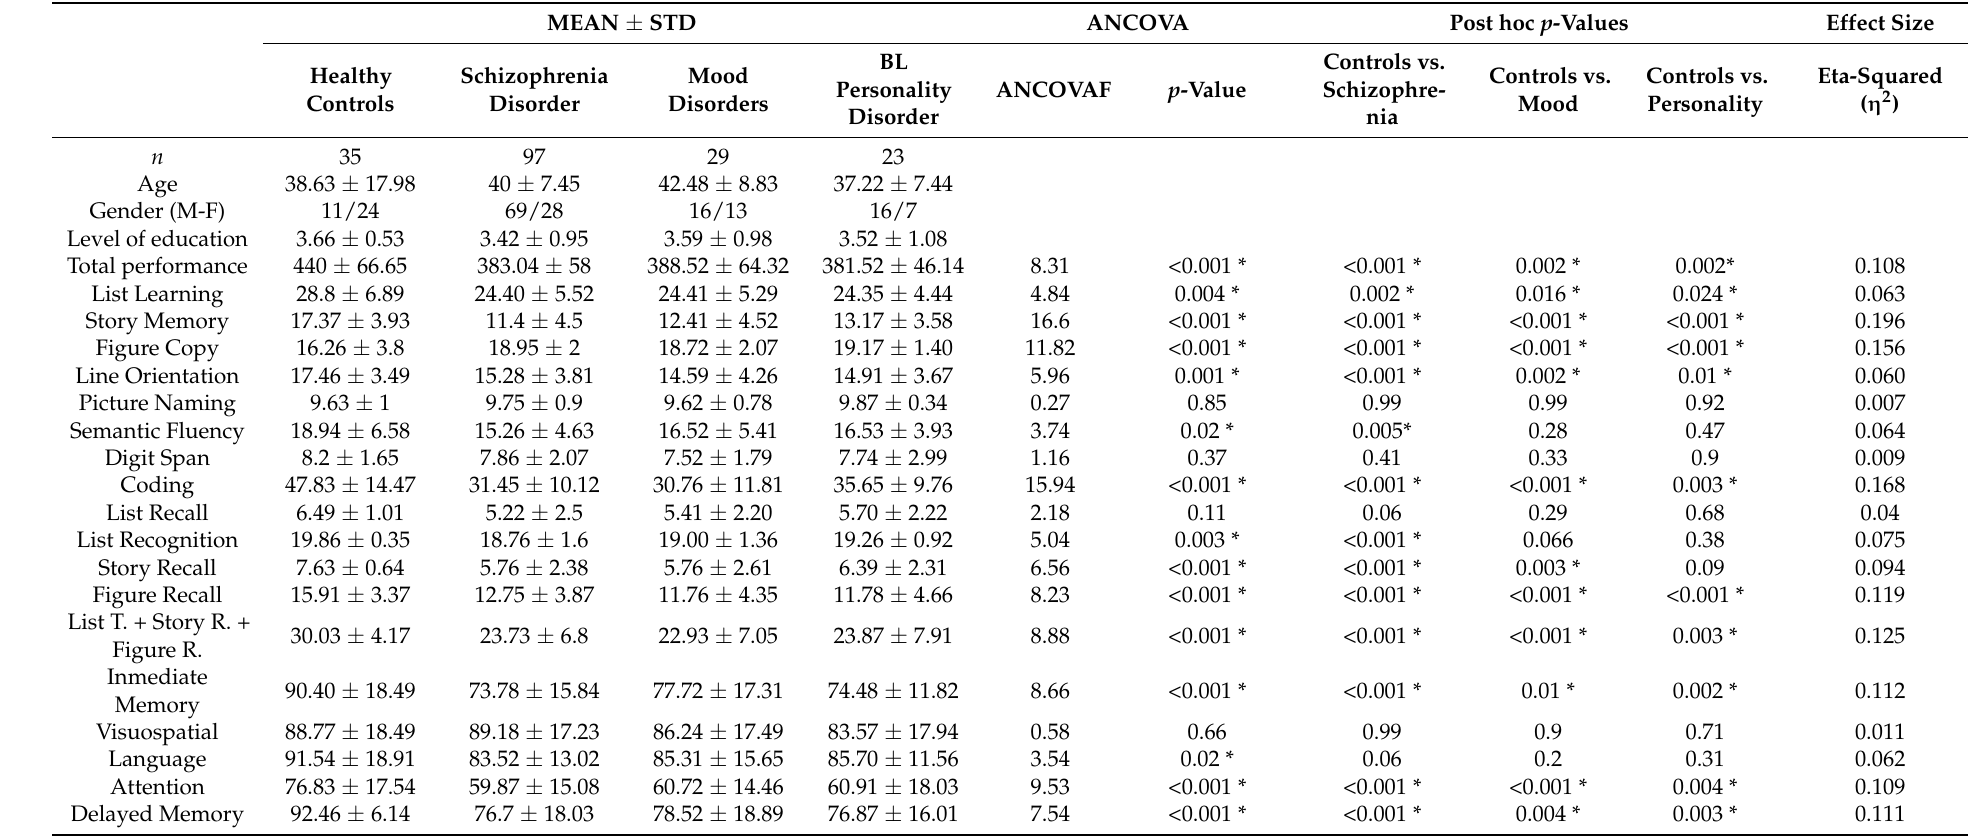
Table 1. Healthy Controls ( n = 35), Schizophrenia ( n = 97), Mood Disorder ( n = 29), and Borderline (BL) Personality Disorder ( n = 23). Mean ± standard deviation information is shown in the left part of the table. ANCOVA p -values after FDR correction ( q = 0.05) are shown in the middle and post hoc p -values on the right part for each between-group comparison. Significant p -values were marked with an